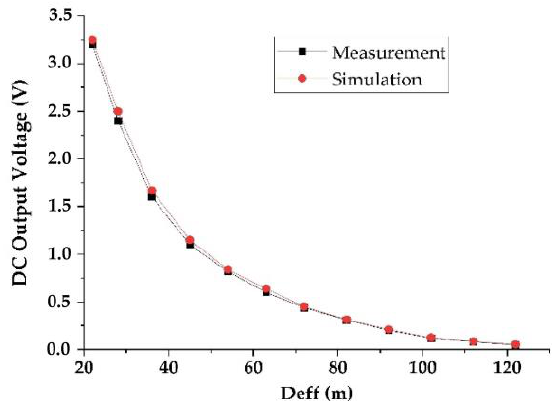
Figure 18. Second architecture with three rectennas matched to GSM-1800, UMTS, and LTE-2.6. Z L2 , Z’ L2 are the impedances at the selected points.